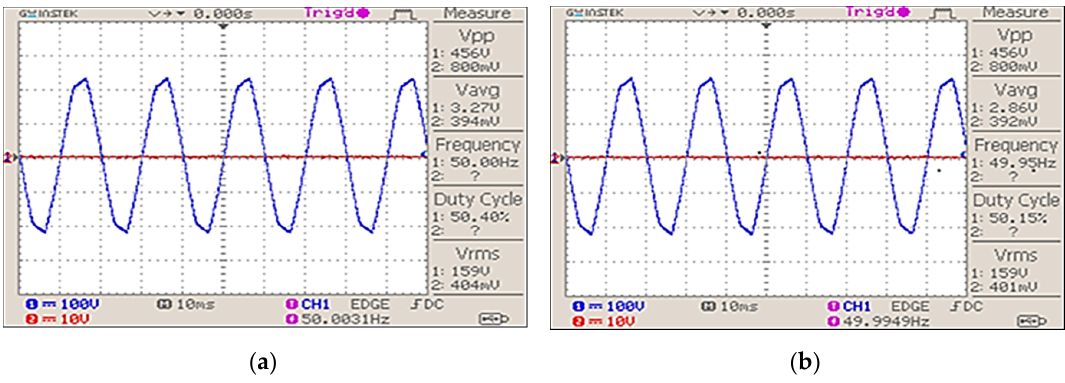
Figure 14. Grid voltage during ( a ) starting and ( b ) execution. Electronics 2020 , 9 , x FOR PEER REVIEW